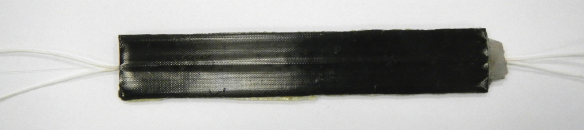
Figure 1: The CFRP laminate with embedded optical